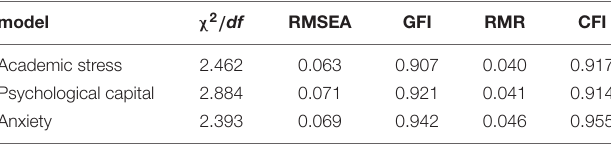
TABLE 2 | Confirmatory factor analysis results of the questionnaire (N = 287).